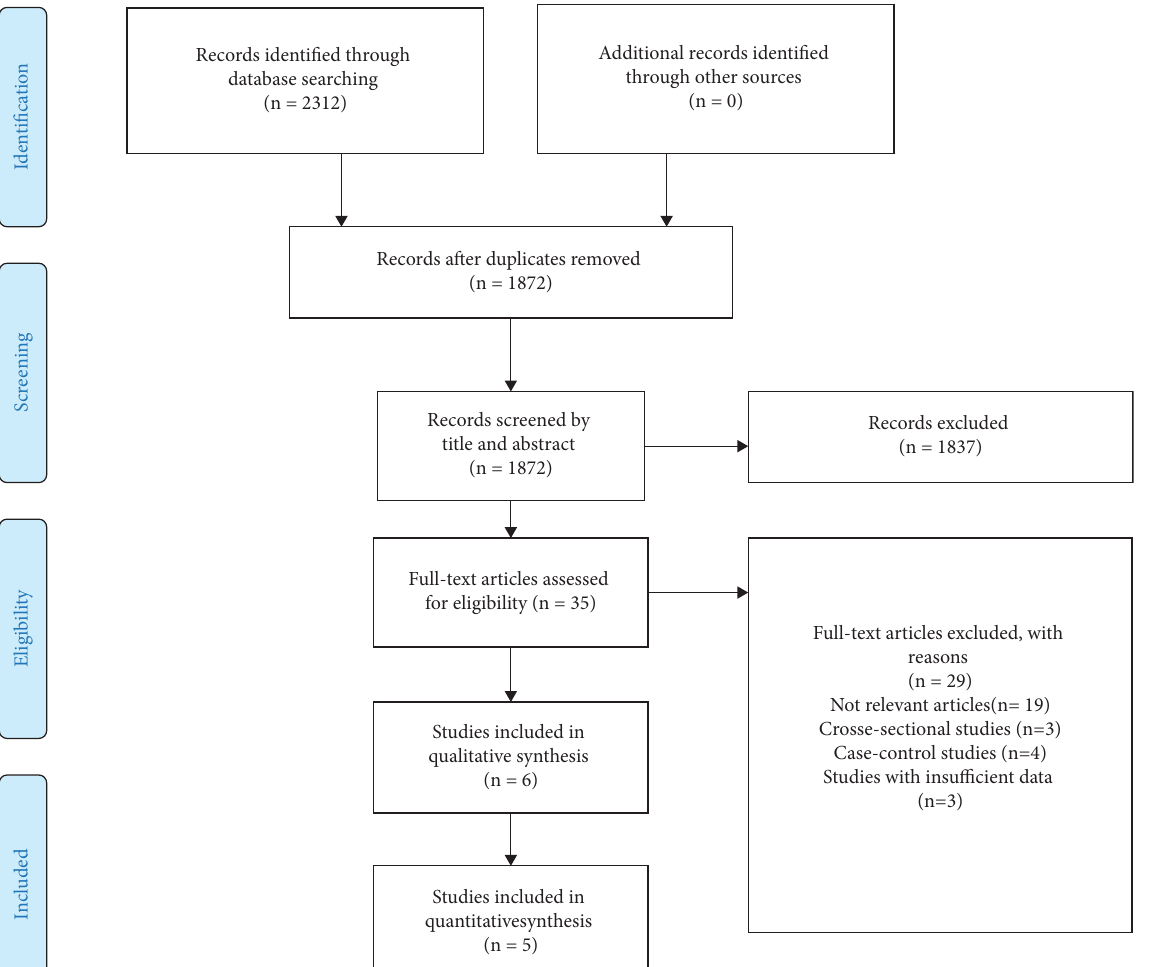
Figure 1: Te fow diagram of study